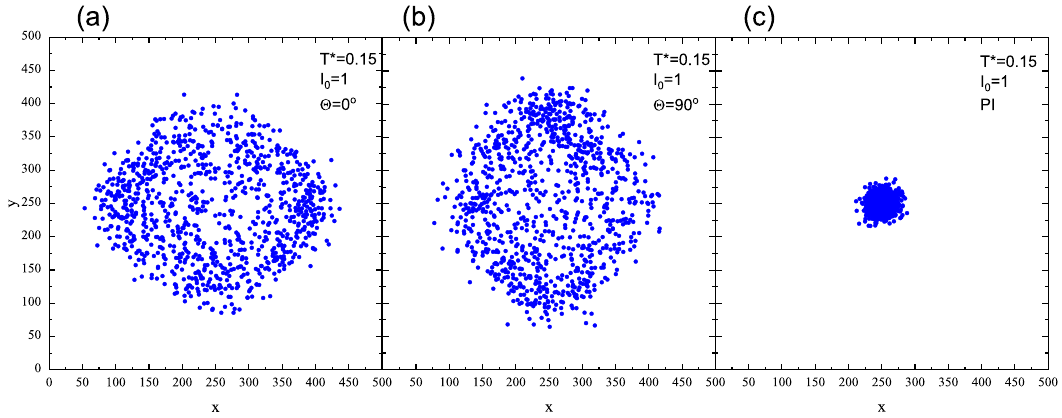
Figure 7. Final positions of CM of 10 3 chains after 10 4 MCS: linear polarization with Θ = 0 ◦ ( a ) and Θ = 90 ◦ ( b ); and PI model ( c ). I = 0